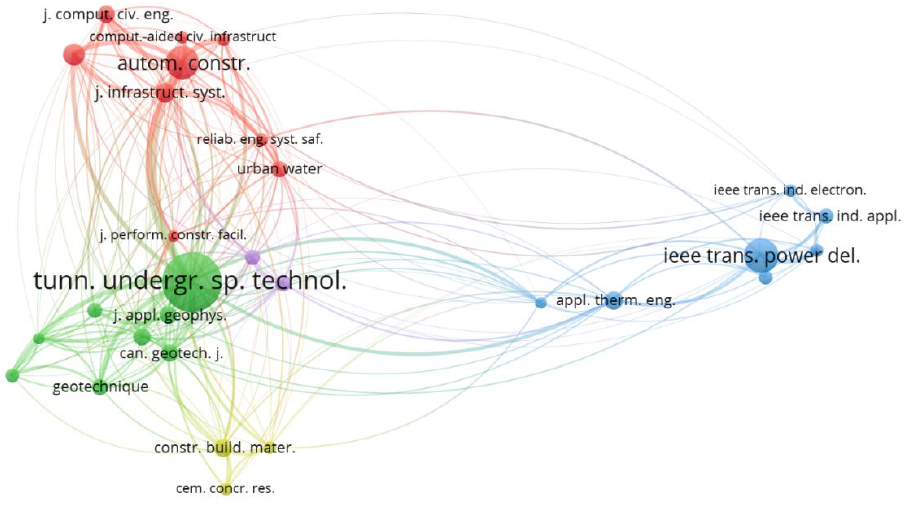
Figure 6. Co-citation analysis of journal sources.